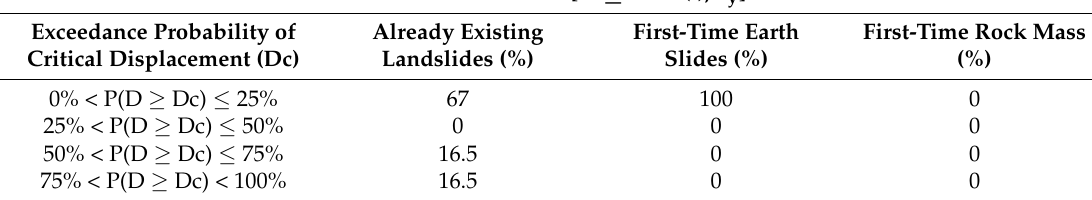
Table 7. Probability of exceedance values computed in the middle saturations scenario for different landslide typologies.